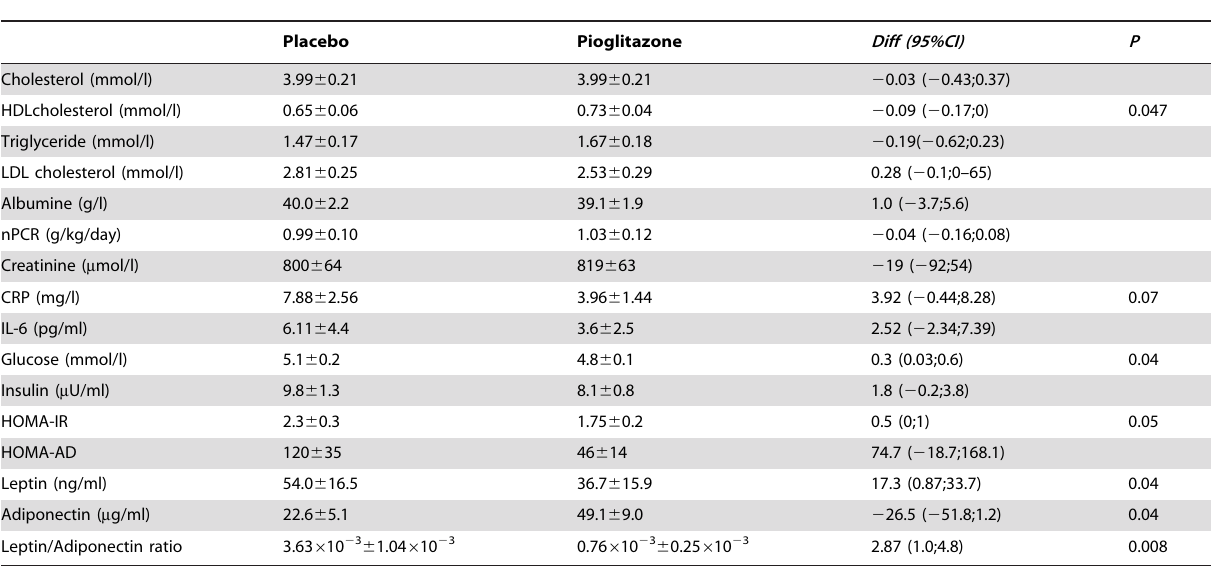
Table 3. Biochemistry values at termination of placebo and pioglitazone